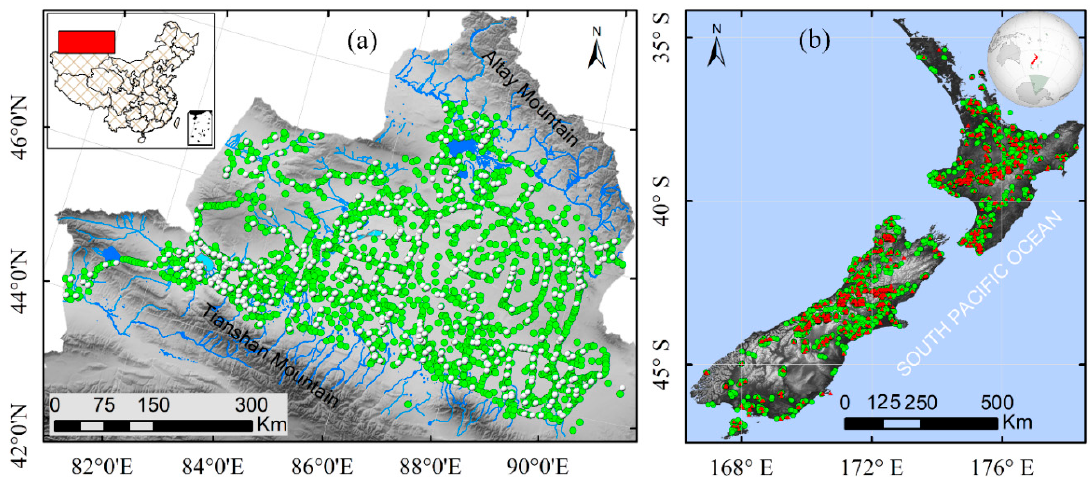
Figure 3. Distribution of sampling points of ( a ) Dzungarian Basin (DzB) and ( b ) New Zealand (NZ). Green circles represent train set while white circles or red triangles represent test sets.